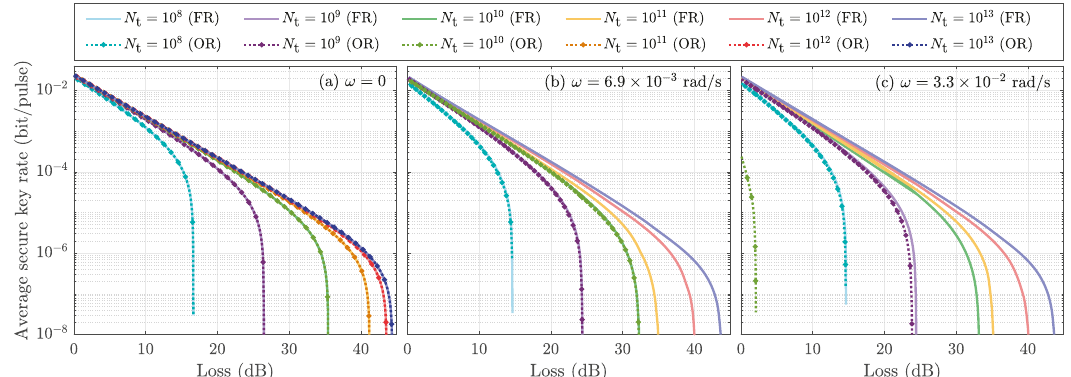
Fig. 6 The simulated secure key rate of our free-running RFI (FR) scheme and the original RFI scheme (OR) with different fi nite lengths ( N t ) and misalignment variation rate ( ω ). Solid lines show the result of our scheme, while the dash lines with dots show the result of the original scheme. a – c show the simulated secure key rate when ω equals to 0, 6.9 × 10 − 3 rad/s and 3.3 × 10 − 2 rad/s, respectively. In b and c , the original RFI scheme couldn't generate secure key when N t ≥ 10 11 . In the simulation, the dataset size m and ρ 0 are